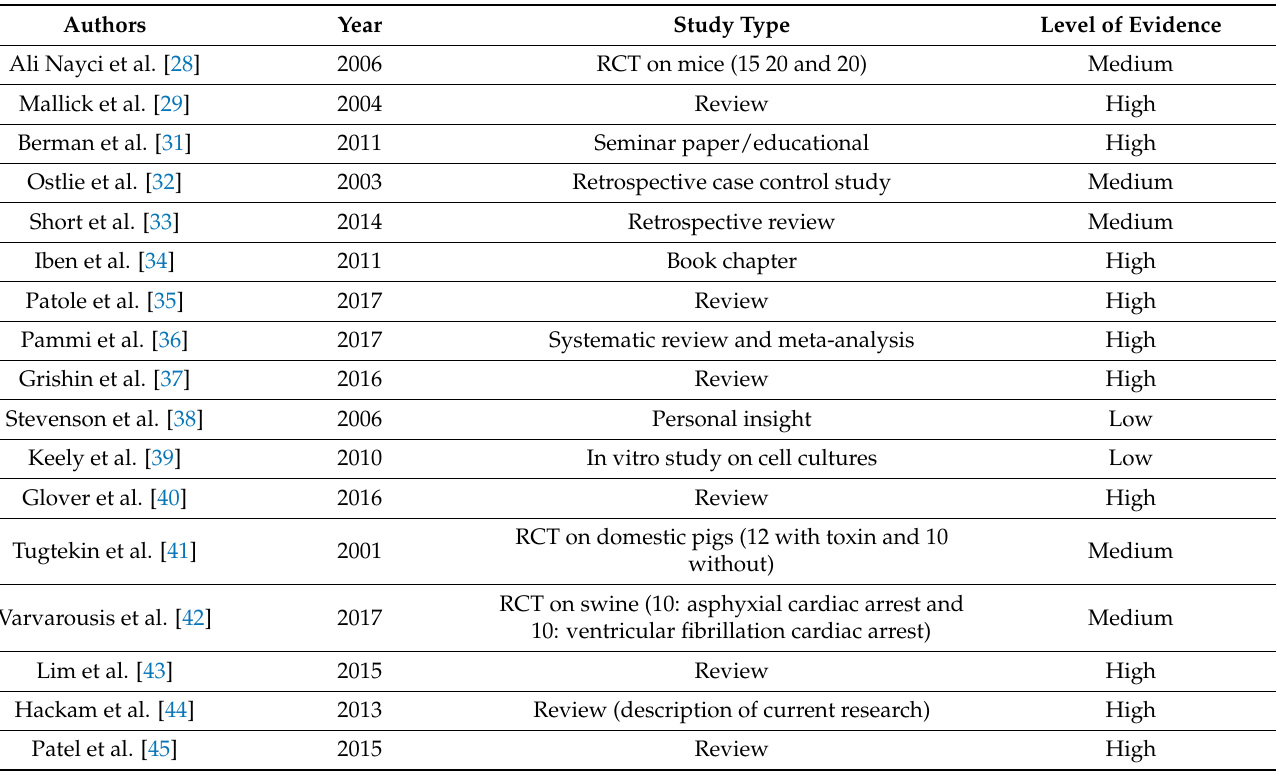
Table A3. The relationship between gut microbiota, intestinal barrier function and microbial translo- cation and necrotizing enterocolitis.